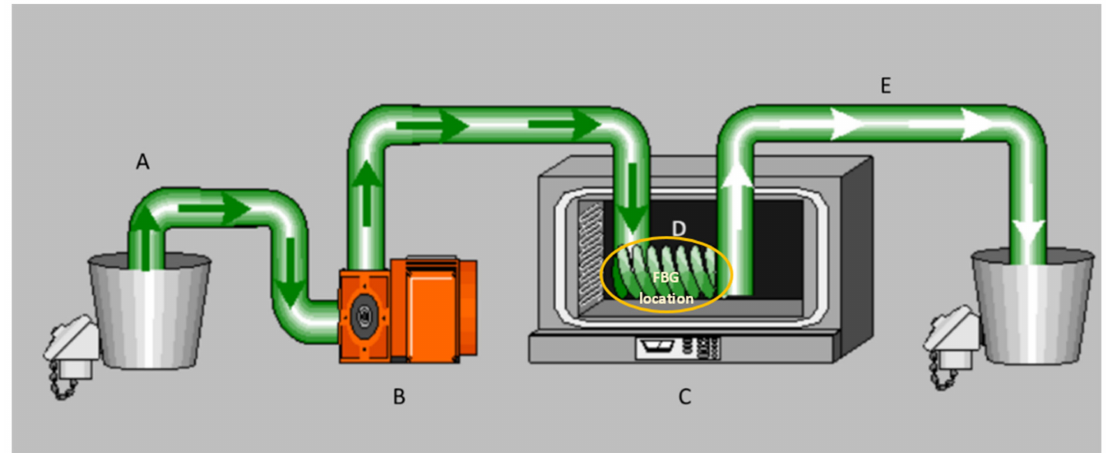
Figure 1. Device prototype scheme based on a modified microwave oven. A : Input Liquid container, B : Flow control system, C : Modified microwave, D : Glass pipe in coiling form for locating Fiber Bragg Grating (FBG) sensors, E : Output Liquid